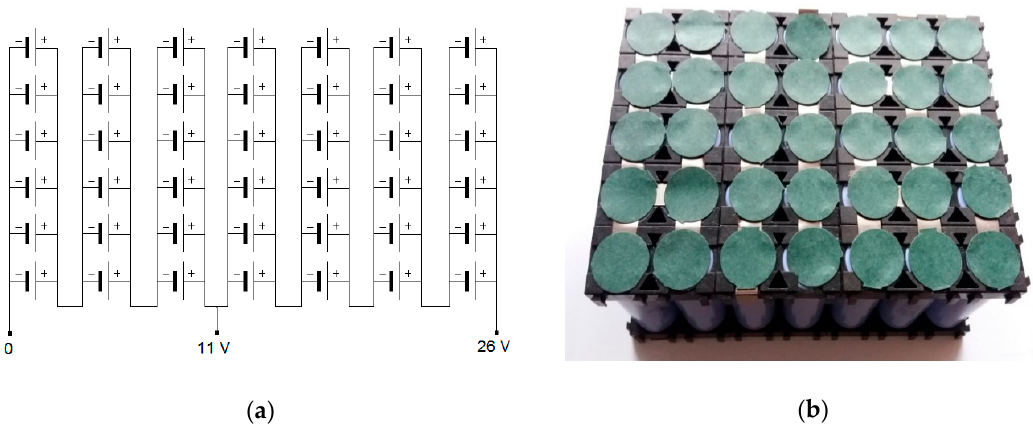
Figure 4. Energy storage unit built of lithium-ion batteries (18,650 type): scheme of electric connections ( a ) and image of built unit ( b ).